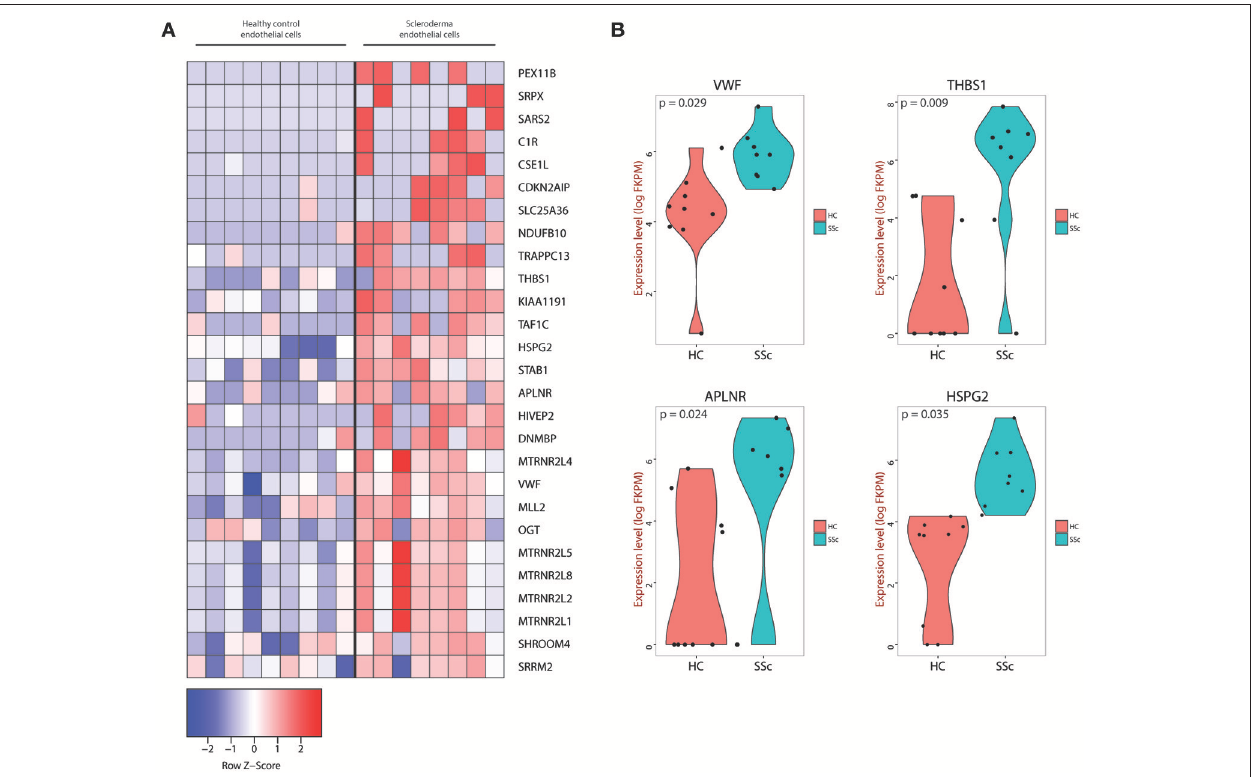
FIGURE 2 | (A) Heatmap of genes that were at least two-fold upregulated in SSc endothelial cells compared to endothelial cells isolated from healthy skin. (B) Violin plots for the VWF , THBS1 , APLNR, and HSPG2 genes showing the expression level and density of expression for the endothelial cells from HC and SSc skin. The corresponding p -values are also depicted for each